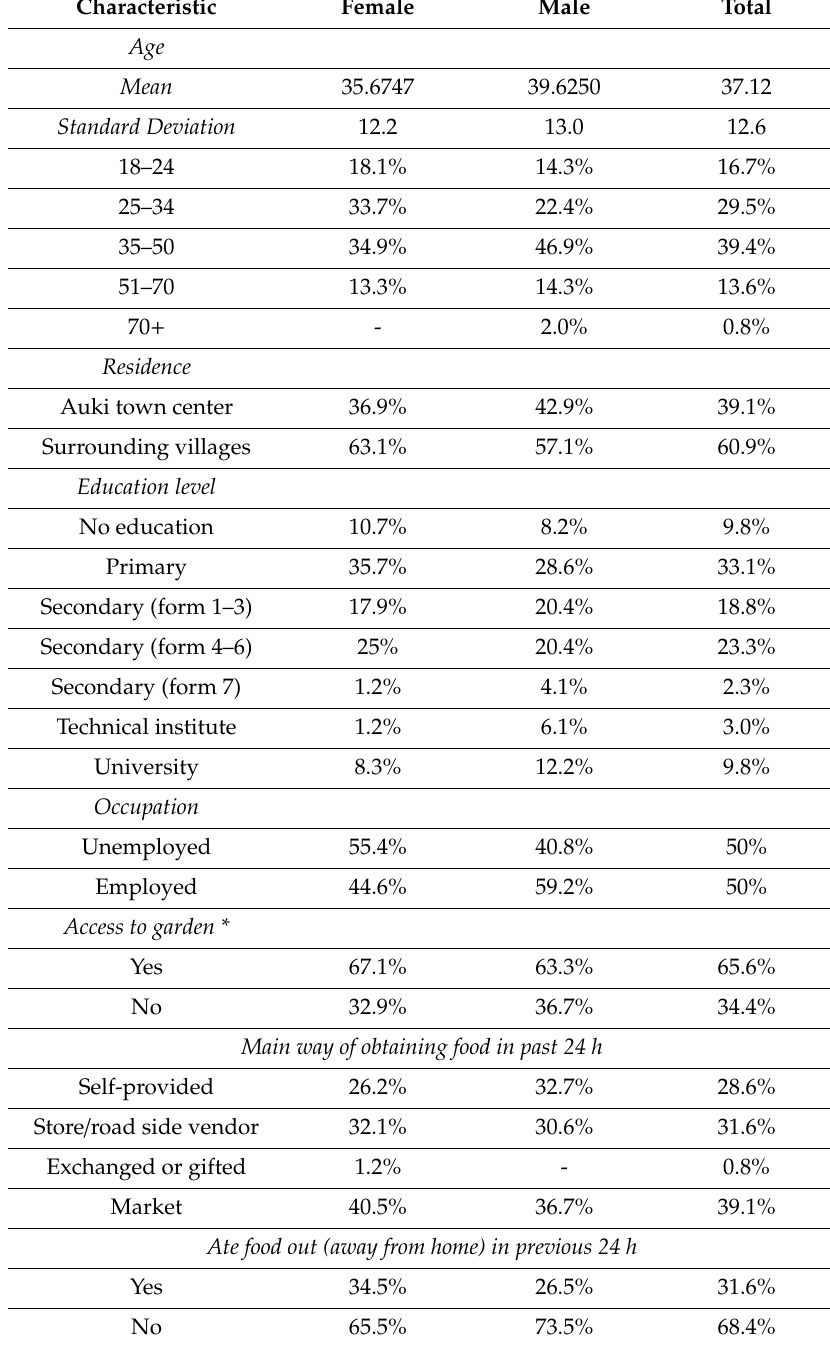
Table 1. Participants’ sociodemographic characteristics (n =